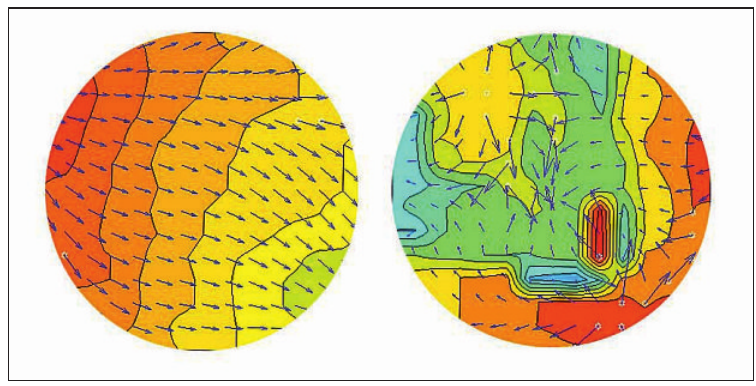
Activation time maps showing wave propagation over the atrial free wall. Isochronal lines indicate 5 ms time differences; earliest activation is in red, latest in blue. Arrows represent local direction of propagation. White stars mark sites of supra-normal local conduction velocities due to oblique activation. Diameter of the mapping area dis- played is 48 mm. Left: Homogeneous fast propagation of a single wave during sinus rhythm. Right: Complex activation pattern during AF with a broad wave coming from the right and lower side, a second wave originating in the left upper quadrant leading to a “breakthrough” pattern with radial spread of activation and a number of smaller waves.The narrow spaces between some isochronal lines represent slow conduction, the wide spaces areas activated almost